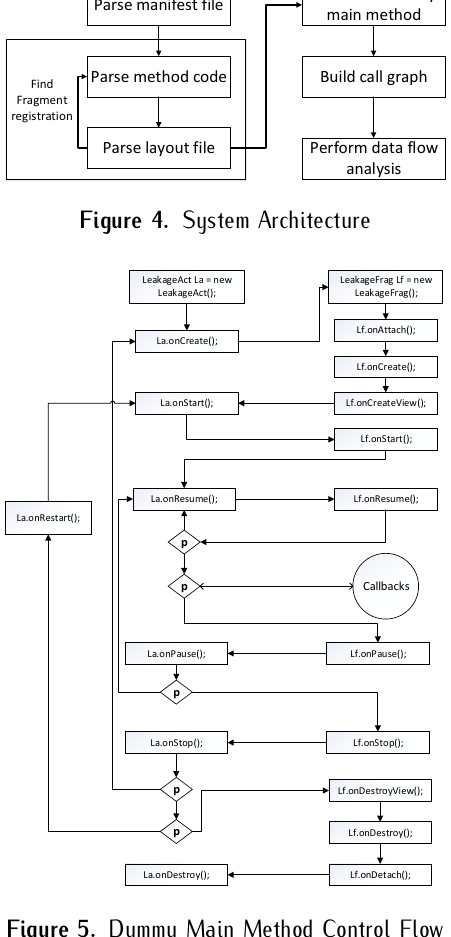
Figure 5. Dummy Main Method Control